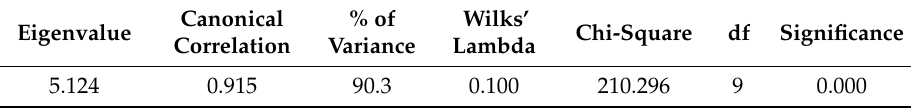
Table 15. Canonical correlation and the significance of discriminant function.